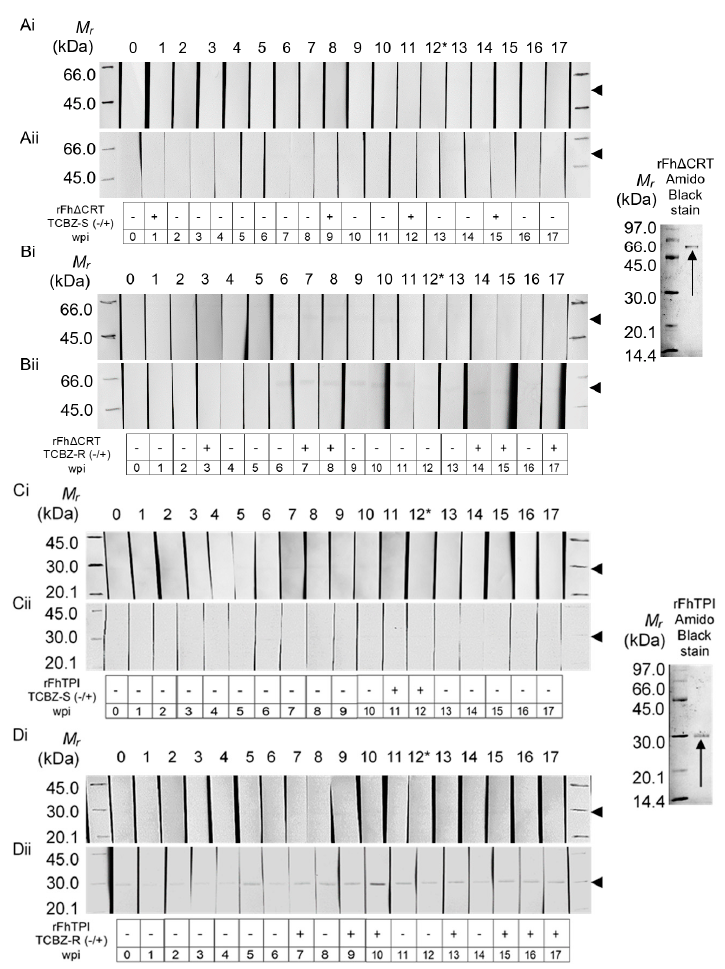
Figure 3. Quantitative representation of duplicate western hybridisations for recombinant biomarker immunogenicity testing against triclabendazole-susceptible (TCBZ-S) and TCBZ-resistant (TCBZ-R) Fasciola hepatica- infected sheep IgG. rFh Δ CRT (0.25 µg/lane) ( A , B ) and rFhTPI (0.25 µg/lane) ( C , D ) were probed with whole sheep sera diluted to 1:1500 and pooled from three animals experimentally infected with TCBZ-susceptible (TCBZ-S; A , C ) or TCBZ-resistant (TCBZ-R; B , D ) F. hepatica isolates, and subsequently detected for IgG binding via the 5–bromo-4–chloro-3–indolyl-phosphate and nitro blue tetrazolium (BCIP/NBT) system. Data from duplicate western hybridisations were analysed ( i – ii ) and band areas of interest were quantified using ImageQuant TL (GE Healthcare Life Sciences, UK), which calculated positivity (+) or negativity ( − ) by subtracting 0 weeks post infection (wpi) values from each wpi value for each treatment, whereby values that were negative, or negative and positive in both replicates, were considered negative. Nitrocellulose membrane (NCM) transfer of 1-DE-separated recombinant proteins was confirmed using Amido Black staining. Abbreviations: M r , Amersham Low Molecular Weight SDS Calibration Kit (kilodaltons); 0–17, weeks post-infection; *, TCBZ administration.